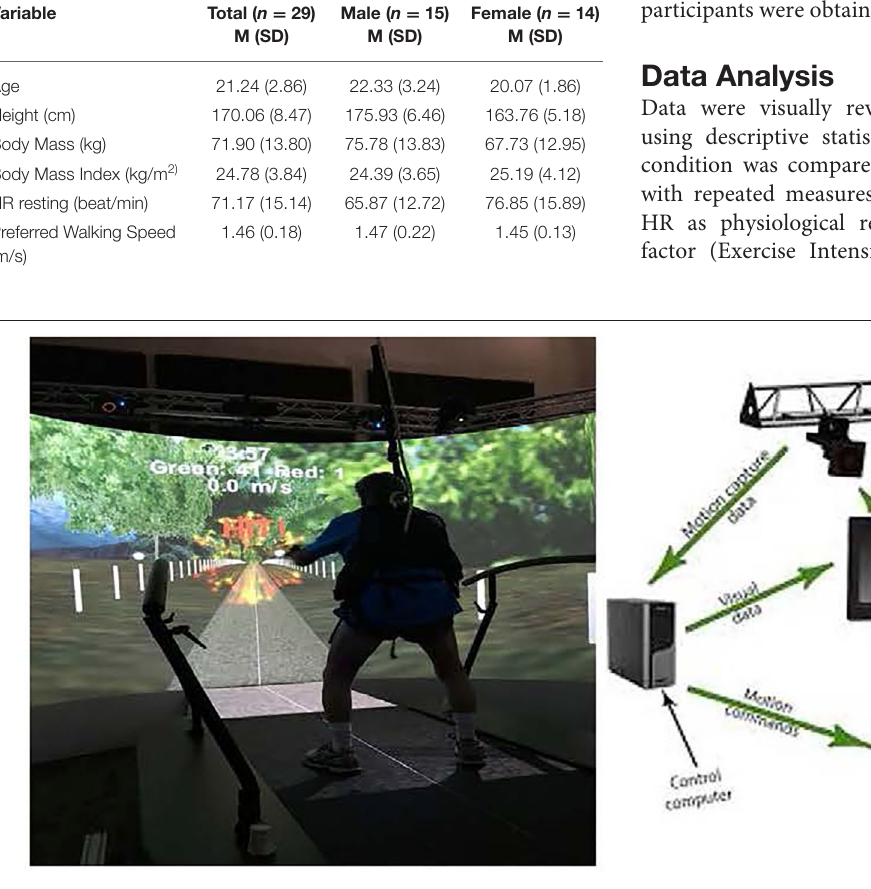
FIGURE 2 | Visual and auditory feedback through VR screen during the dual-tasking condition.